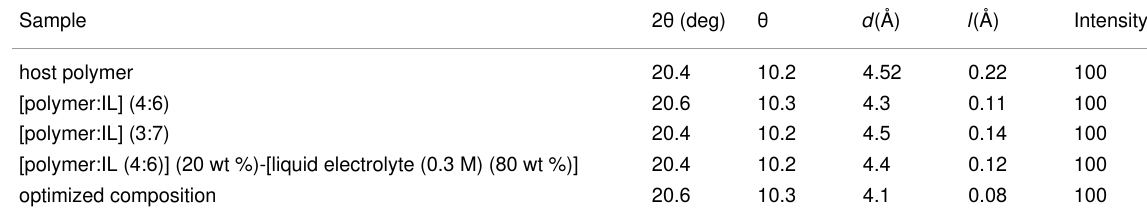
Table 1: Values of the parameters obtained from X-ray diffraction of ionic liquid-based polymer gel electrolytes. Sample